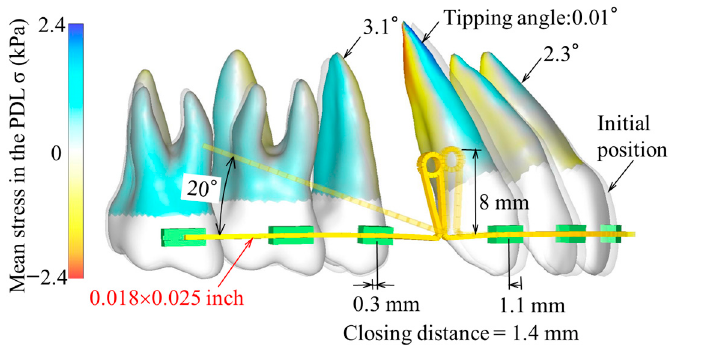
Figure 6. Effect of the wire size. When the wire size increases, closing distance C and the number of repeated calculations N b decreases.